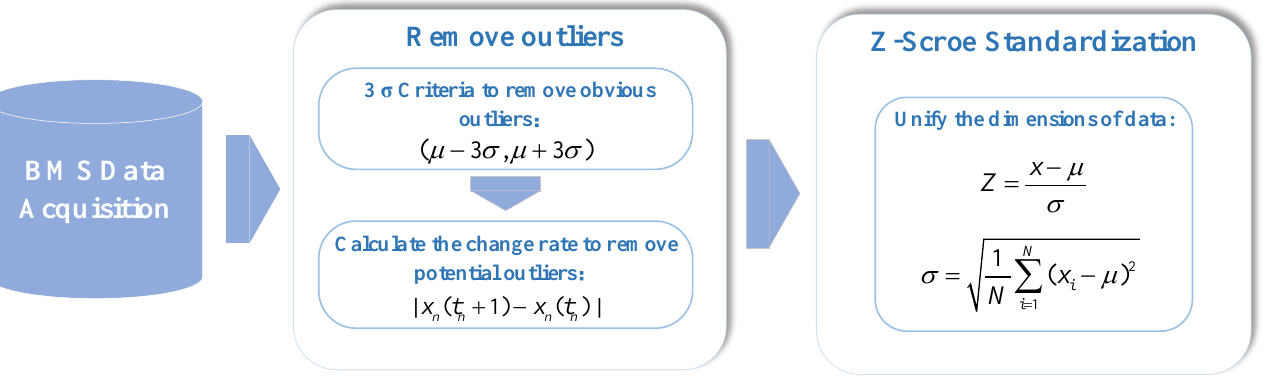
Figure 6. Data pre-processing process.